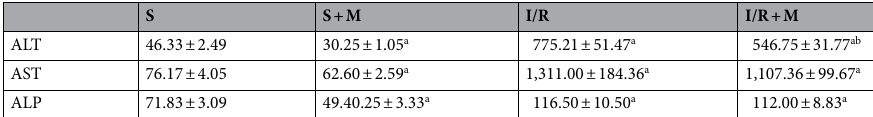
Table 5. The serum alanine aminotransferase (ALT), aspartate aminotransferase (AST), and alkaline phosphatase (ALP) activities (IU/L). Experimental group abbreviations: S sham-operated rat group, S + M sham-operated + meldonium rat group, I/R ischemia/reperfusion rat group, I/R + M ischemia/ reperfusion + meldonium rat group. The number of animals per experimental group: n = 8. The data are given as mean ± standard error of the mean. Minimal significant level: p < 0.05. Significantly different: a in respect to S group; b in respect to I/R group.